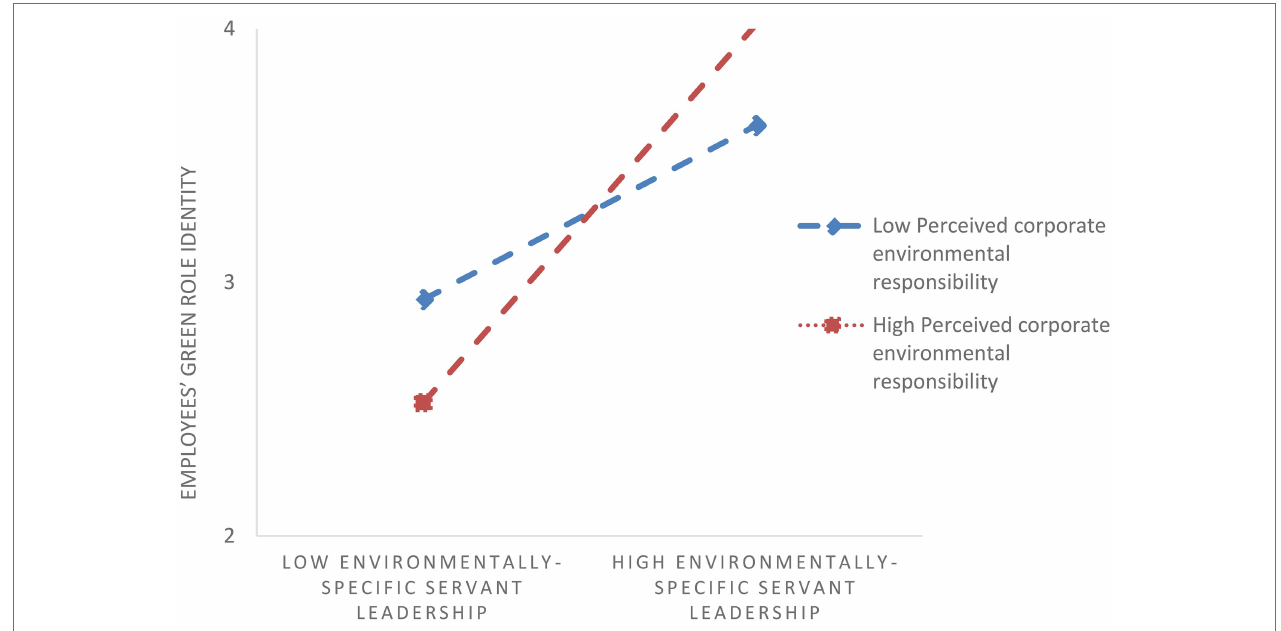
FIGURE 2 | Interaction between environmentally-specific servant leadership and perceived corporate environmental responsibility in predicting employees’ green role